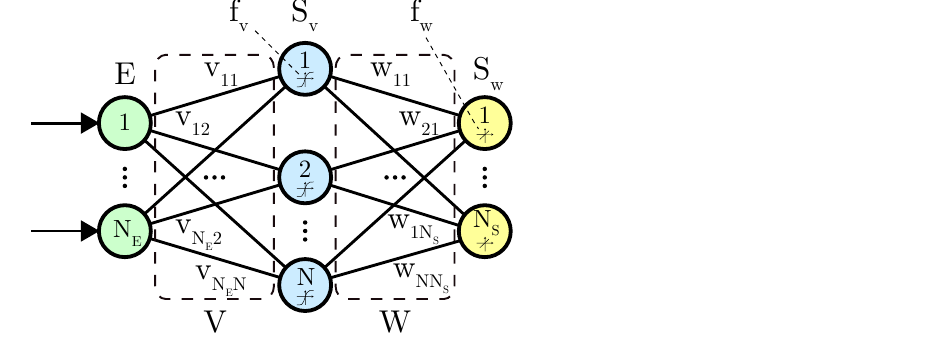
Figure 1. The ANNs architecture implemented this work, composed by one hidden layer of 20 neurons.